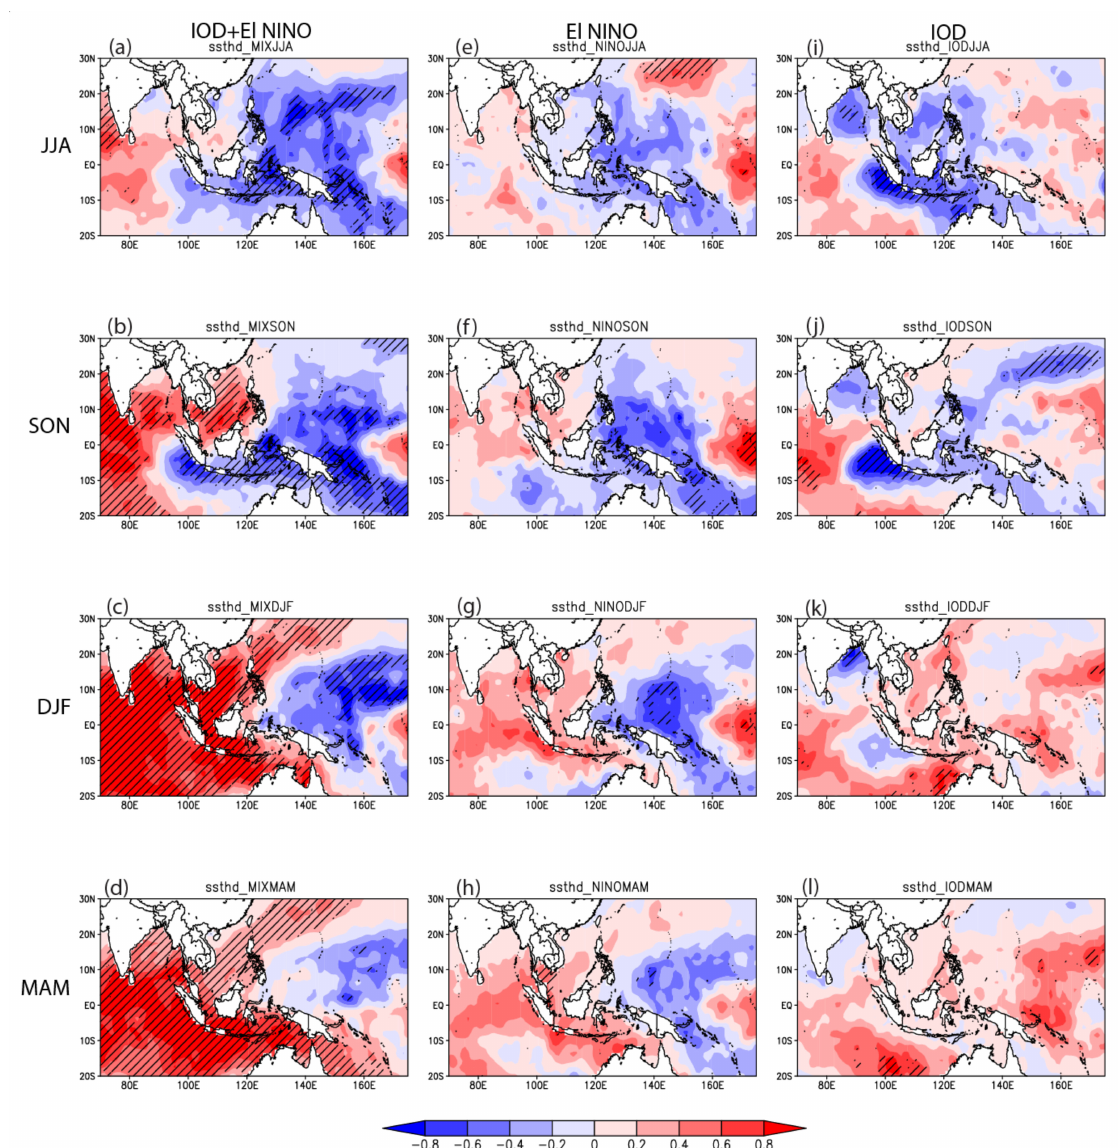
Figure 3. The composite of anomalous sea surface temperature (SST) for the events listed in Table 1. The hatched area indicates significance at the 95% level. ( a – d ) Co-occurrence of the conventional El Niño and positive IOD, ( e – h ) pure conventional El Niño, and ( i – l ) pure positive IOD for the seasons of JJA, SON, DJF, and MAM. Unit is degrees